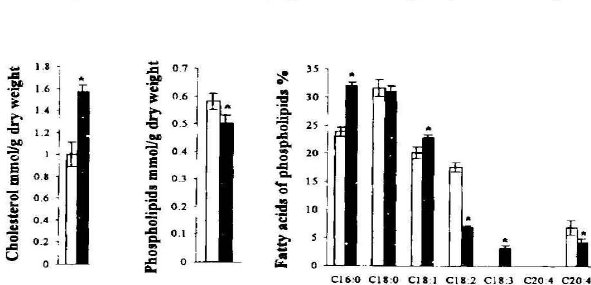
Figure 1. Concentration (mean±S.D.) of cholesterol and phospholipids, as well as fatty acid content (in percent: mean ± S.D.) of phospholipids in controls (open bars) and samples with 4 nmol/g wet weight L-kynurenine (hatched bars). Samples of rat liver tissue homogenates were used to test for phospholipid biosynthesis in vitro. Incubation medi um: Krebs -Ringer- phosphate buffer, containing 0.3% al bumin (pH=7.4), fatty acid mixture and glycerol. Samples were incubated twice for 4 h at